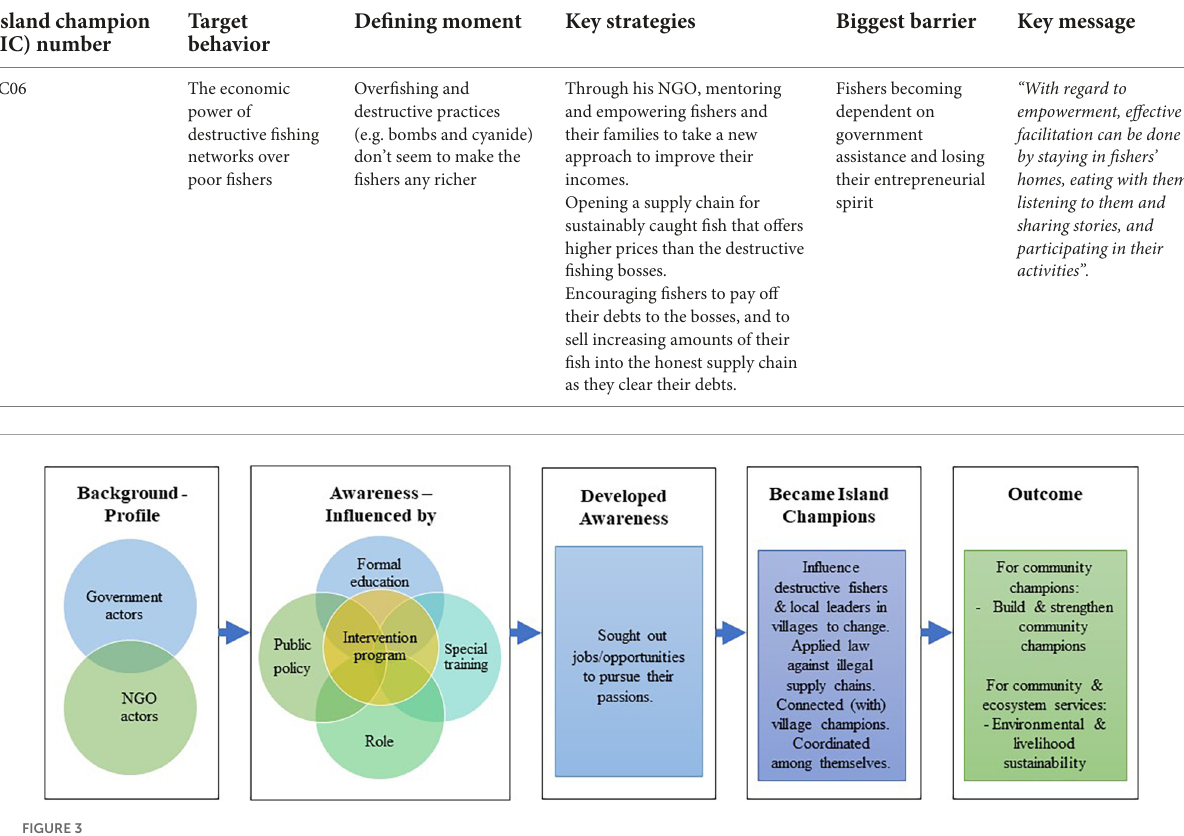
FIGURE3 Emergence process of island